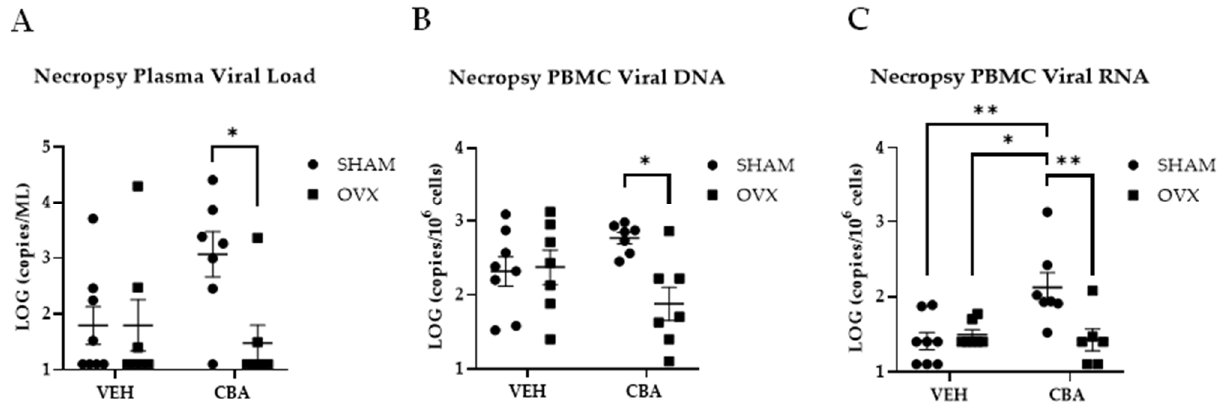
Figure 2. Plasma and PBMC viral loads. ( A ) CBA/SHAM animals had a higher plasma viral load compared to CBA/OVX animals. ( B ) PBMC viral DNA was higher in CBA/SHAM compared to CBA/OVX animals. ( C ) PBMC viral RNA was higher in CBA/SHAM compared to all other groups. A LOG value of 1.1 was used for SIV-infected samples that had undetected virus. Vehicle (VEH)/sham surgery (SHAM) ( n = 8), VEH/ovariectomy (OVX) ( n = 7), chronic binge alcohol (CBA)/SHAM ( n = 7), and CBA/OVX ( n = 7). Two-way ANOVA and Tukey’s multiple comparison test. * p ≤ 0.05, ** p ≤ 0.01.